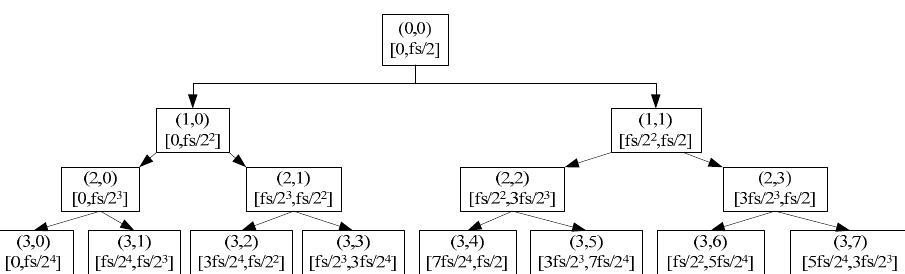
Figure 1. The three-layer wavelet packet decomposition tree and the frequency band division.